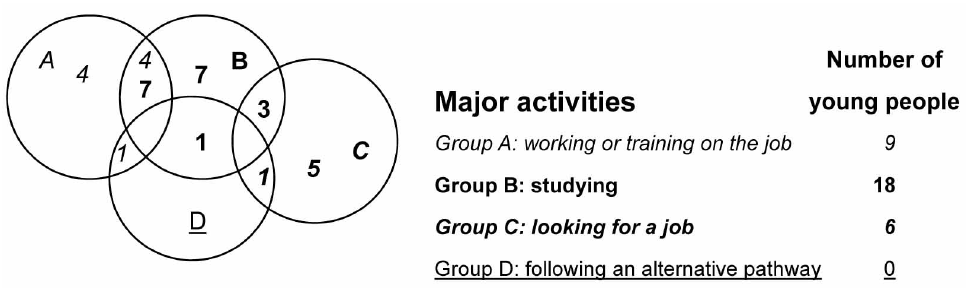
Figure 1: Young people’s